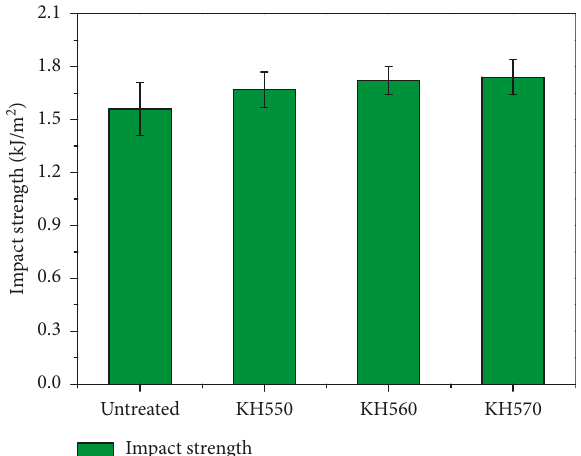
Figure 5: Impact strength of TPR cement slurry modified by different silane coupling agents.